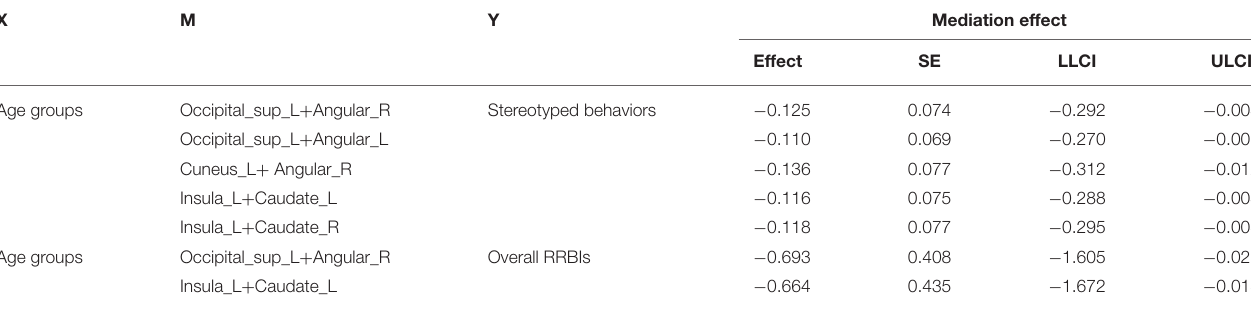
TABLE 5 | Functional connectivity that mediated associations between age and stereotyped behaviors/overall RRBIs ( n = 147).